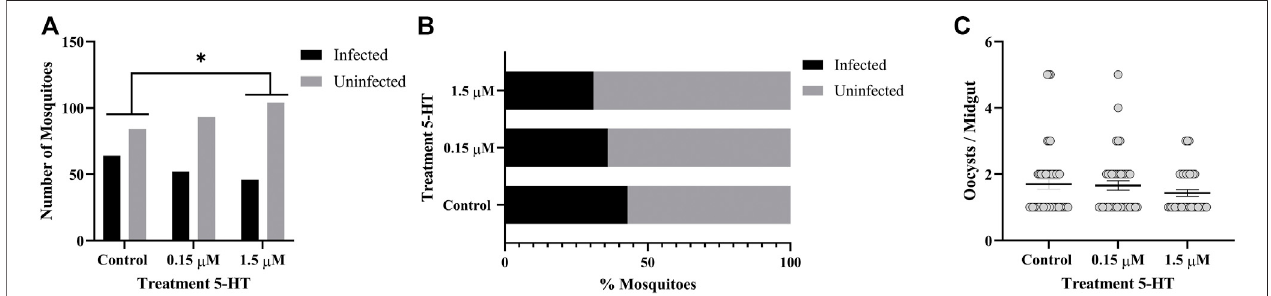
FIGURE 10 | P. falciparum NF54 oocyst infection in A. stephensi following a bloodmeal provisioned with 5-HT or water (control). (A) Numbers of A. stephensi infected with P. falciparum NF54 oocysts, *control vs. 1.5 μ M p = 0.0306, and (B) data from (A) shown as percentages of infected and uninfected mosquitoes in each group. N = 8; Fisher ’ s exact test ( α = 0.05). (C) Mean P. falciparum NF54 midgut oocysts. N = 8; Kruskal-Wallace test ( α = 0.05), no signi fi